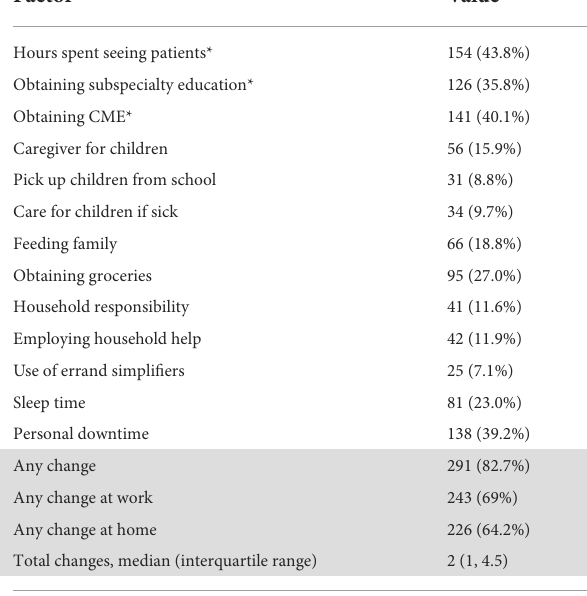
TABLE 1 Demographics and MBI-HSS scales ( n =